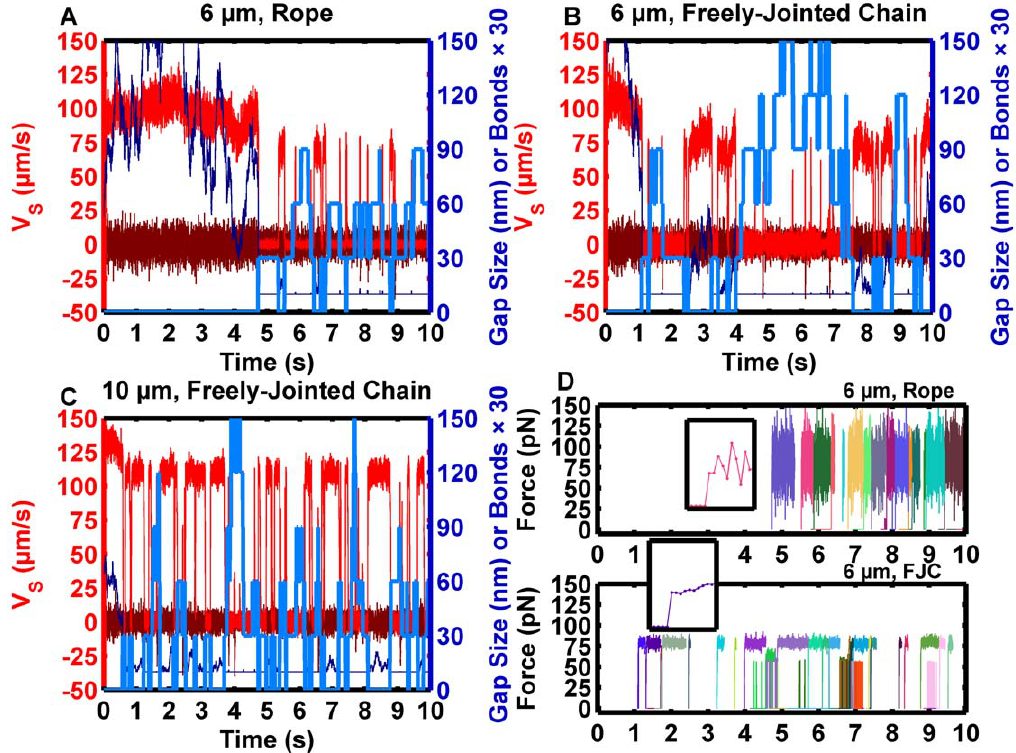
Figure 4. Reactive microsphere motion illustrates the discrete nature of bond formation events and force loading. Reactive spheres were simulated with S=50 s 2 1 , n L u =100 sites/ m m 2 , n R u =50 sites/ m m 2 , association kinetics governed by (1), and dissociation kinetics governed by (3). (A) Results for a 6 m m-diameter sphere with a rope model of bond deformation, (5). Sampled flow-direction velocity (V S,X , red), perpendicular velocity (V S,Y , maroon), gap size (dark blue) and number of bonds (light blue) are shown. (B) Results for a 6 m m-diameter sphere with a freely-jointed chain model of force deformation, (6). An increase in the magnitude of the fluctuations of V S,X was observed with the decrease in stiffness relative to (A). (C) Results for a 10 m m-diameter sphere with a freely-jointed chain model of force deformation, (6). The motion was higher frequency in nature with shorter pauses and more frequent pause events. (D) A comparison of simulated bond loadings for the rope tether results in (A), top, and the freely- jointed chain in (B), bottom. Each sampled point on the inset is spaced by 1 ms. In both cases, the sphere’s pause tended to be supported by a singly- loaded bond. The decreased stiffness of the freely-jointed chain tether resulted in a smaller standard deviation of the supported force. A lower maximum initial force loading was predicted for the freely-jointed chain model than for the rope model (insets).